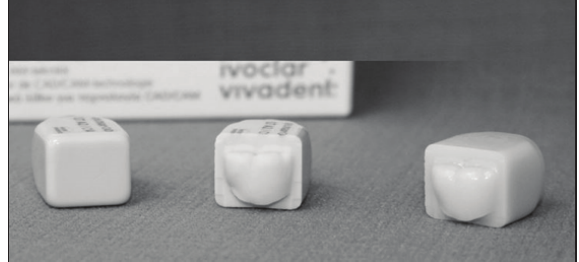
Figure 1. The porcelain samples constructed replicating surface of the mandibular